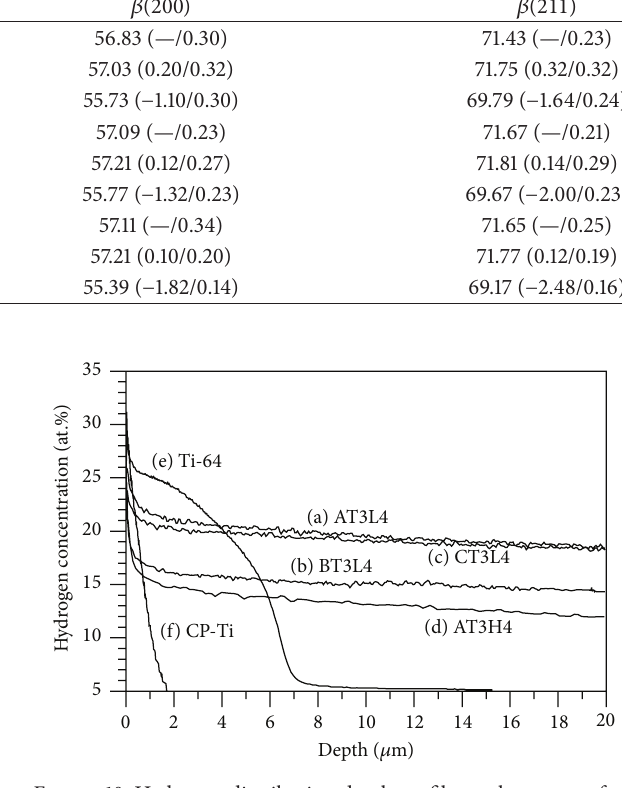
Figure 10: Hydrogen distribution depth profiles at the near surface after (a) AT3L4, (b) BT3L4, (c) CT3L4, and (d) AT3H4 treatments. The depth profiles for the treatments similar to AT3H4 and AT3L4 performed on (e)Ti-64 and (f)CP-Tirespectively were also attached for